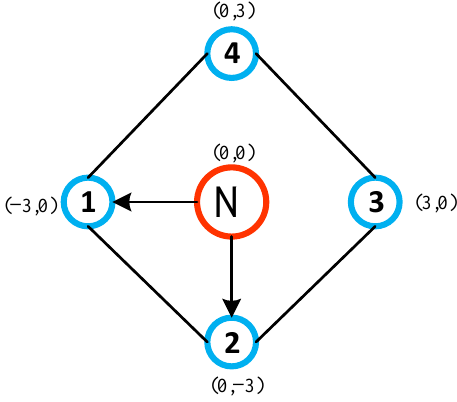
Figure 3. The communication graph of the vehicles.